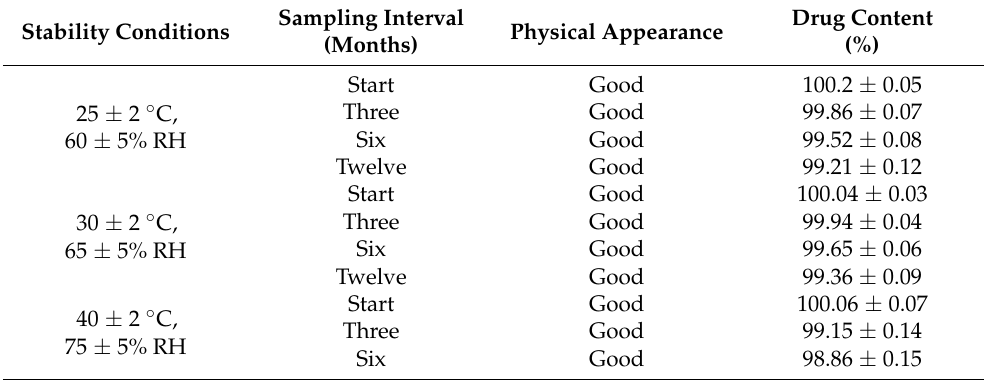
Table 6. Stability